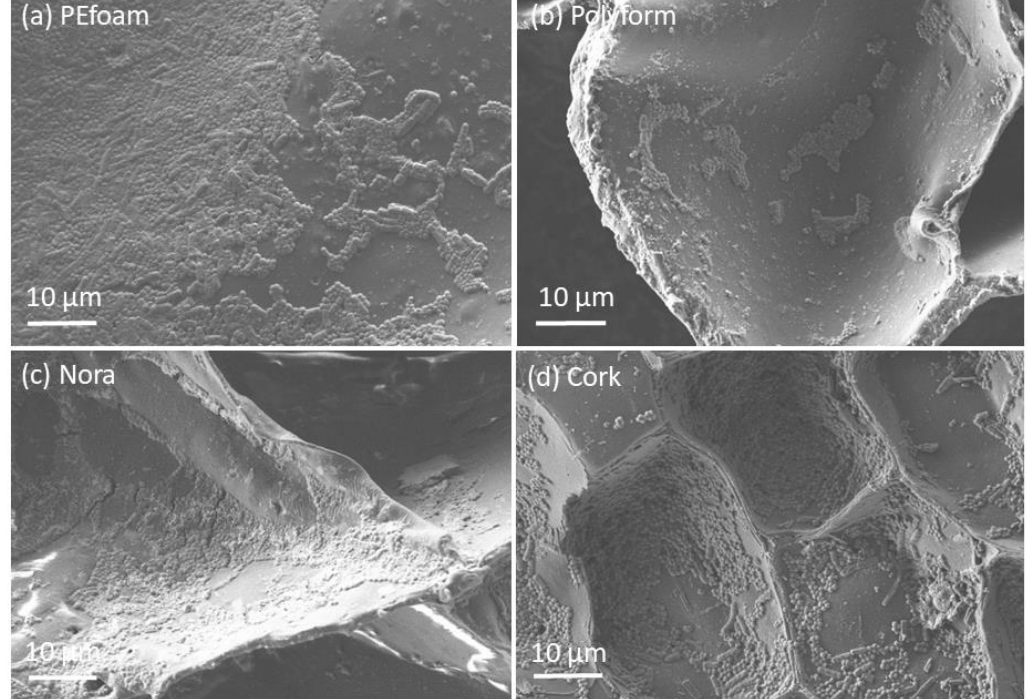
Figure 6. FE-SEM micrographs of the surface of foamed polymer samples; bacterial adhesion on ( a ) PEfoam, ( b ) Polyform, ( c ) Nora and ( d ) cork.